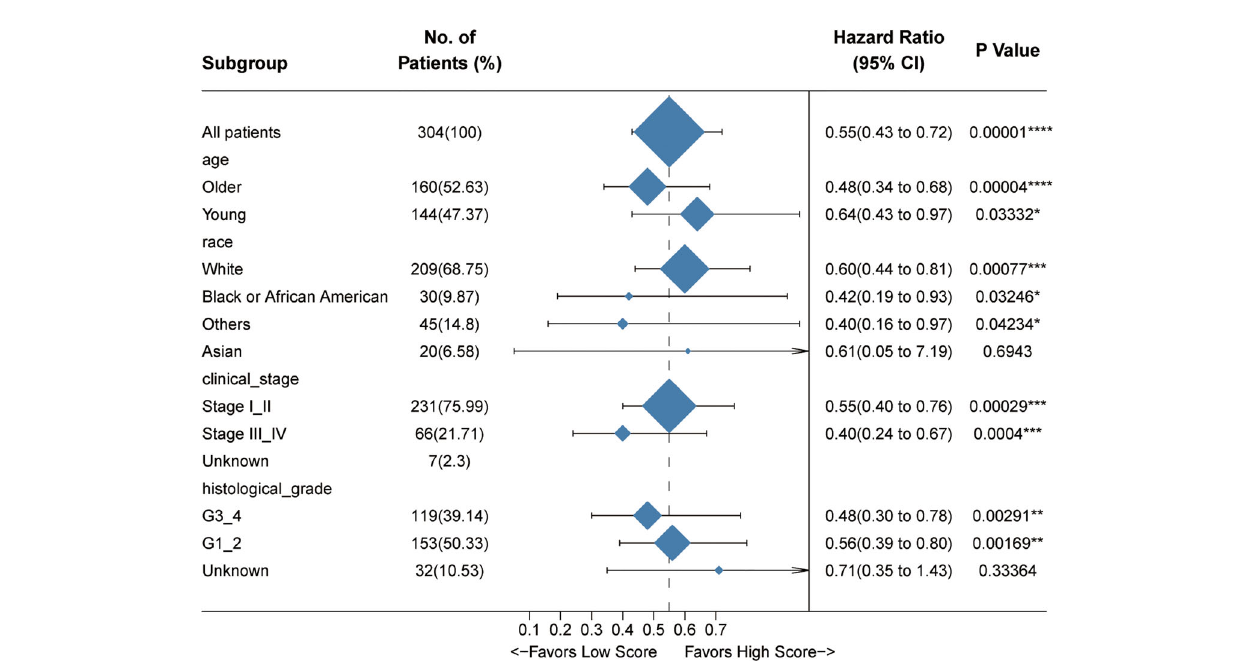
FIGURE 4 | Internal validation of the prognostic potential of the Immunoscore. A univariate Cox hazard ratio analysis revealed that the Immunoscore was statistically different in almost all the subgroups classi fi ed by age, race, clinical stage, and histological grade. *p < 0.05, **p < 0.01, ***p < 0.001, ****p <